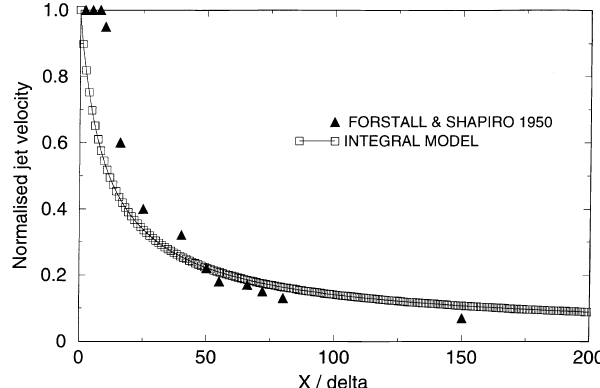
Fig. 3. Normalised velocity as a function of downstream distance X = (cid:68) , where (cid:68) is the exhaust jet diameter. Comparison with the Forstall and Shapiro (1950)